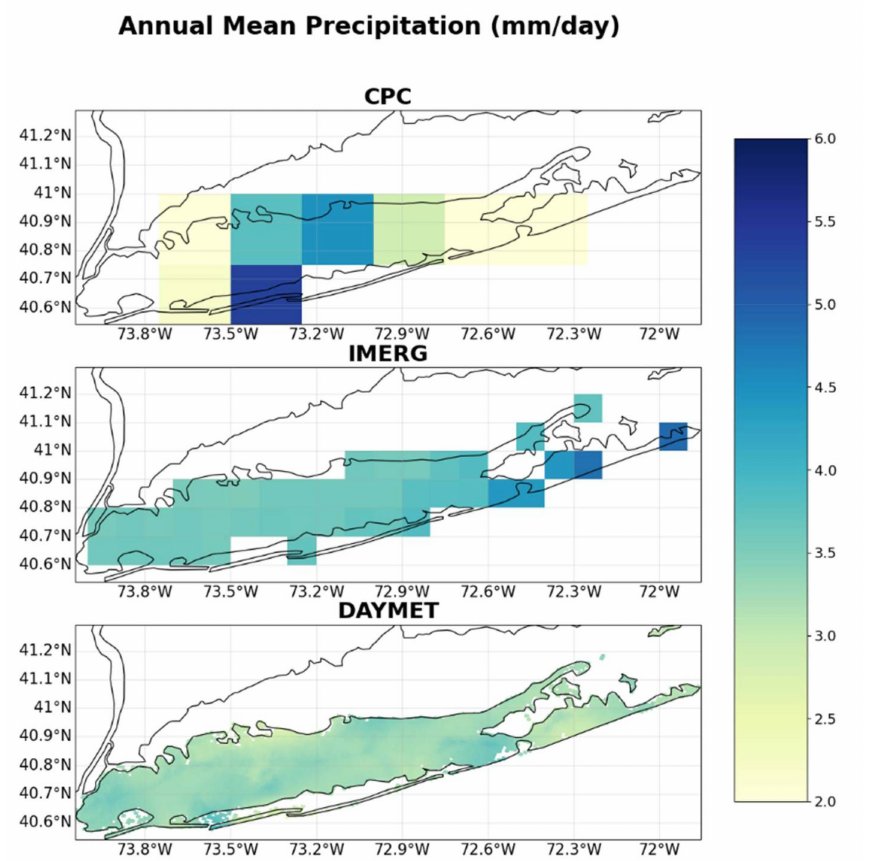
Figure 1. Annual average daily precipitation (mm/day) over the common time period (2001–2020) for ( top ) CPC, ( middle ) IMERG, and ( bottom )